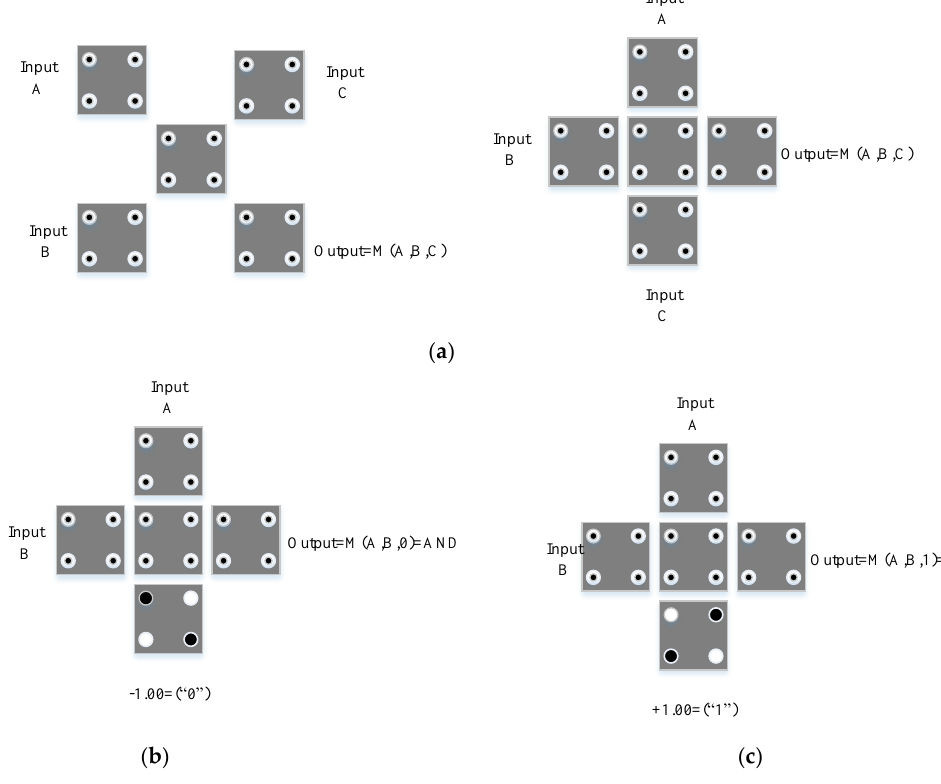
Figure 4. Two different Not-gate in QCA based on 90° cells.